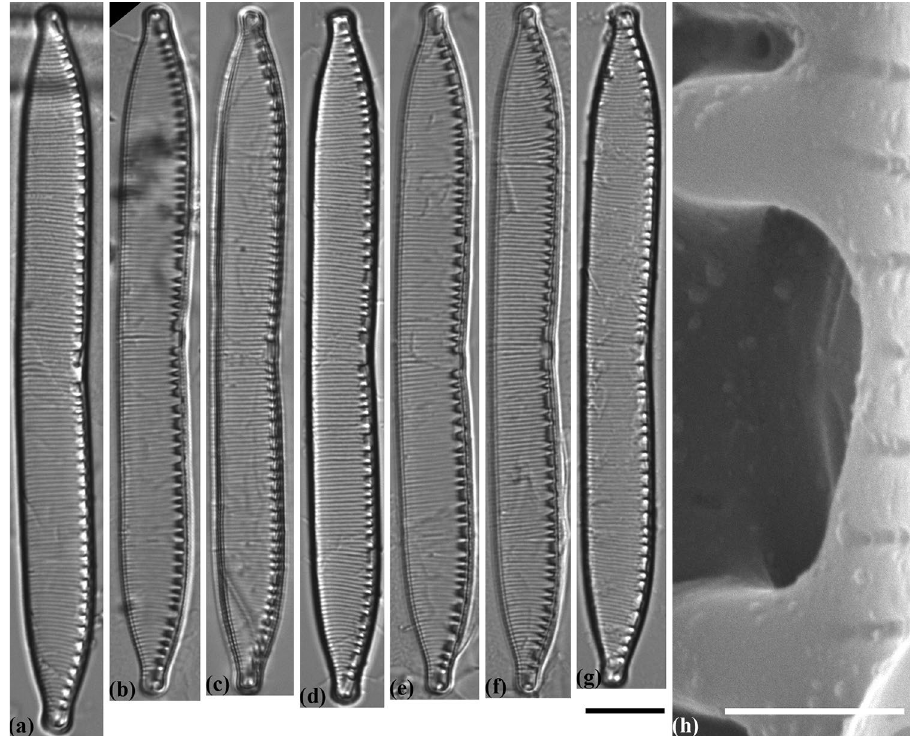
Figure 5. Valve morphology of the strain Hantzschia pseudomongolica (Mo1)a. ( a – c ) Light micrographs of the natural population. ( d – g ) Light micrographs of monoculture. ( h ) Scanning electron micrograph, interior of valve at valve center, showing the position of the central raphe endings. Scale bars ( a – g ) = 10 µm, ( h ) = 1